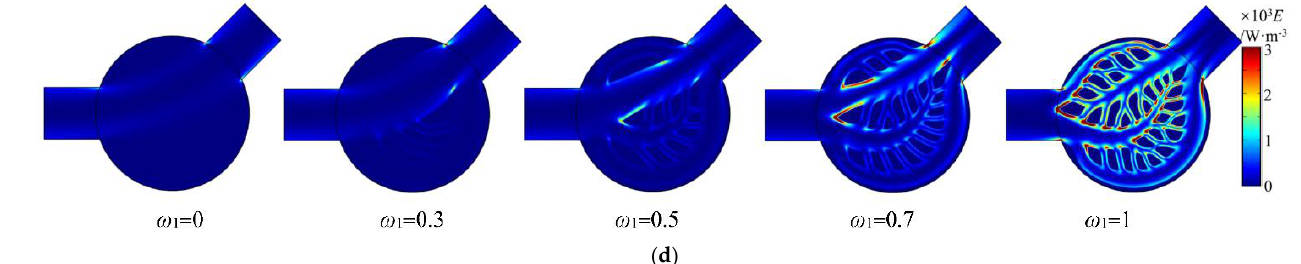
Figure 6. Variation of optimal topology, velocity field, temperature field and energy dissipation density field distribution with ω 1 . ( a ) Optimal topology; ( b ) Velocity field; ( c ) Temperature field; and ( d ) Energy dissipation density field.